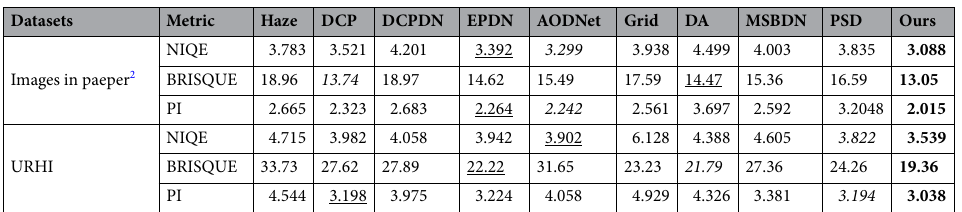
Table 3. Quantitative comparison results on the images in paper 2 and URHI datasets. Number in bold, italics, and underline indicate the first, second, and third best results, respectively. Lower values of NIQE, BRISQUE, and PI represent better performance.